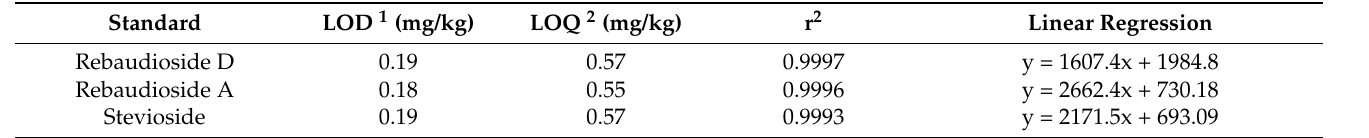
Figure 4. Calibration curve of the dependence of a peak area on the steviol glycoside concentration. ( a ) Rebaudioside D; ( b ) Rebaudioside A; ( c ) Stevioside; ( d ) Rebaudioside F; ( e ) Rebaudioside C; ( f ) Dulcoside A; ( g ) Rubusoside; ( h ) Rebaudioside B; and ( i ) Steviobioside. Table 1. Validation and monitoring test for steviol glycosides.